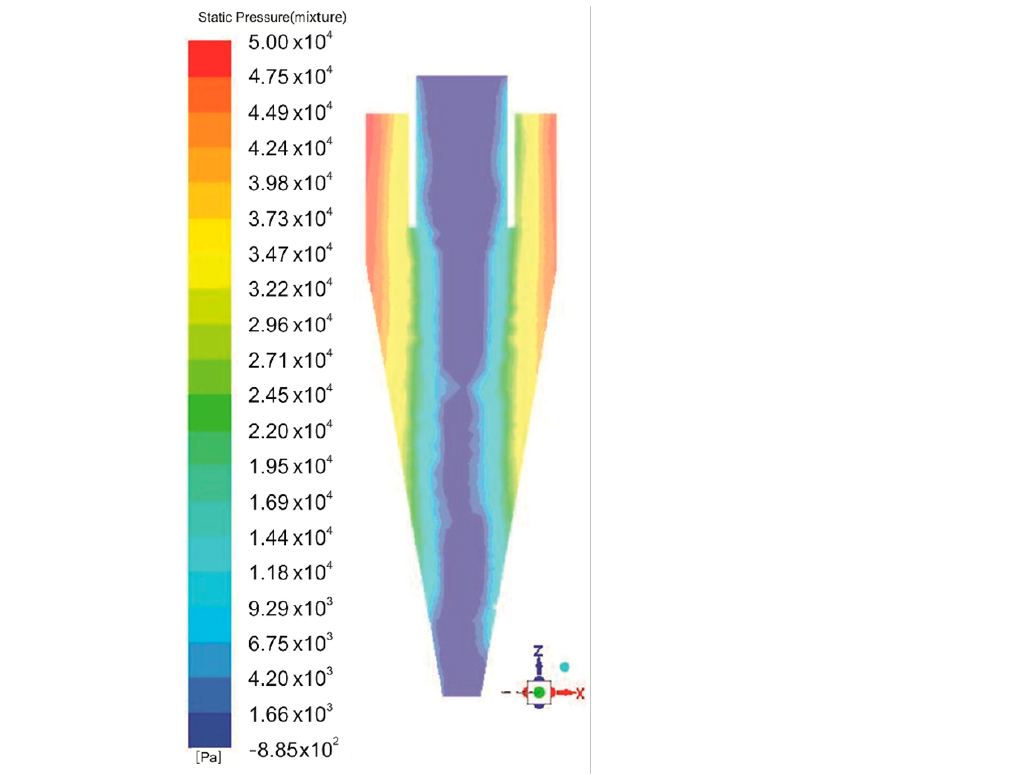
1,000.0 10.0100.0 Figure 11. Static pressure distribution with the increasing axial depth in the plane y = 0 mm inside the TPHS under different inlet velocity. 4. Conclusions In this study, the three products hydrocyclone screen (TPHS), which has a cylindri- cal screen embedded in a conventional hydrocyclone (CH), has been successfully inves- tigated. Both the CFD simulation with the RSM model and the physical experiment with 0.1 1.0